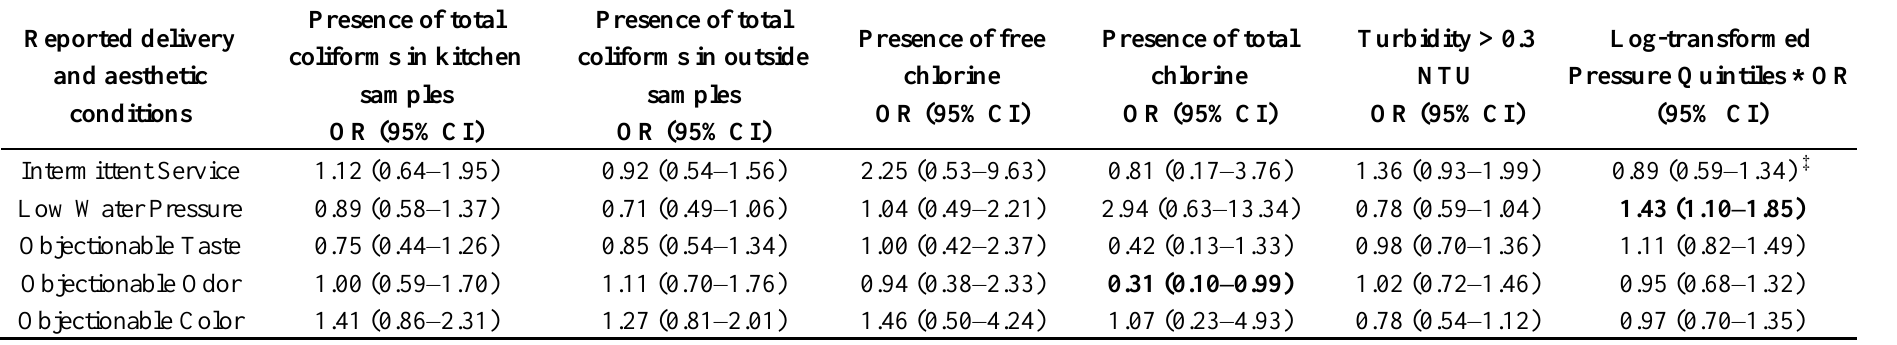
Table A1. Univariable associations between reported delivery and aesthetic conditions and measured water quality in a sample of households of three rural counties in Alabama